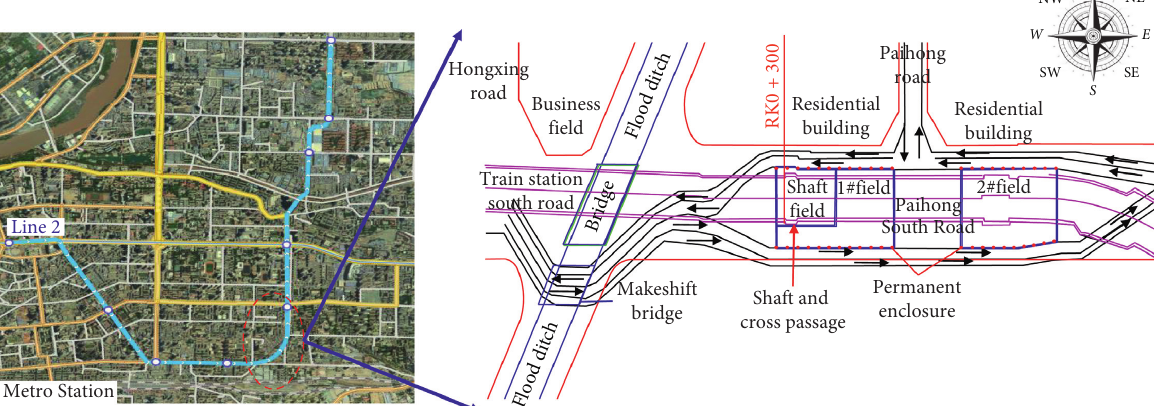
Figure 1: Plane layout of access line